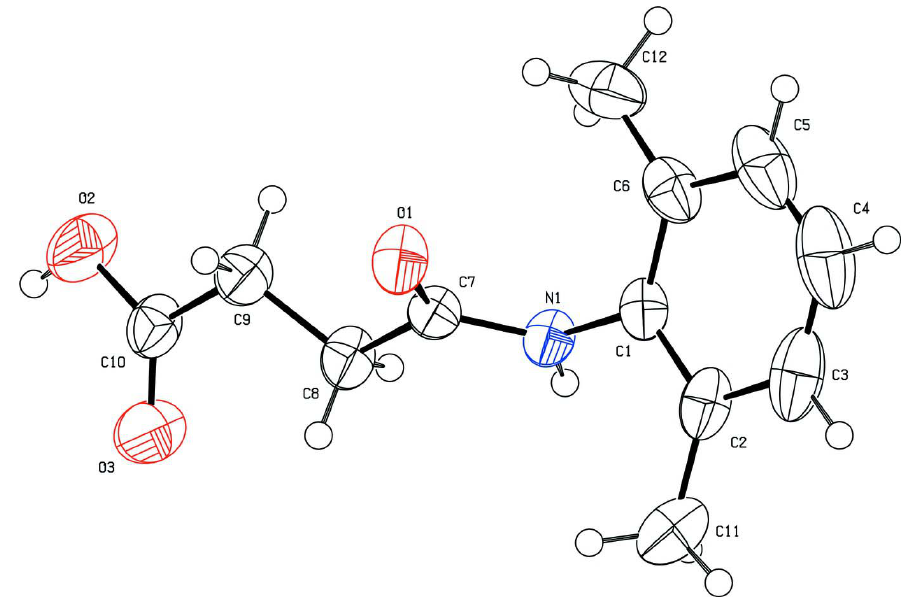
Figure 1 Molecular structure of (I), showing the atom labeling scheme and displacement ellipsoids at the 50% probability level. The H atoms are represented as small spheres of arbitrary radii.